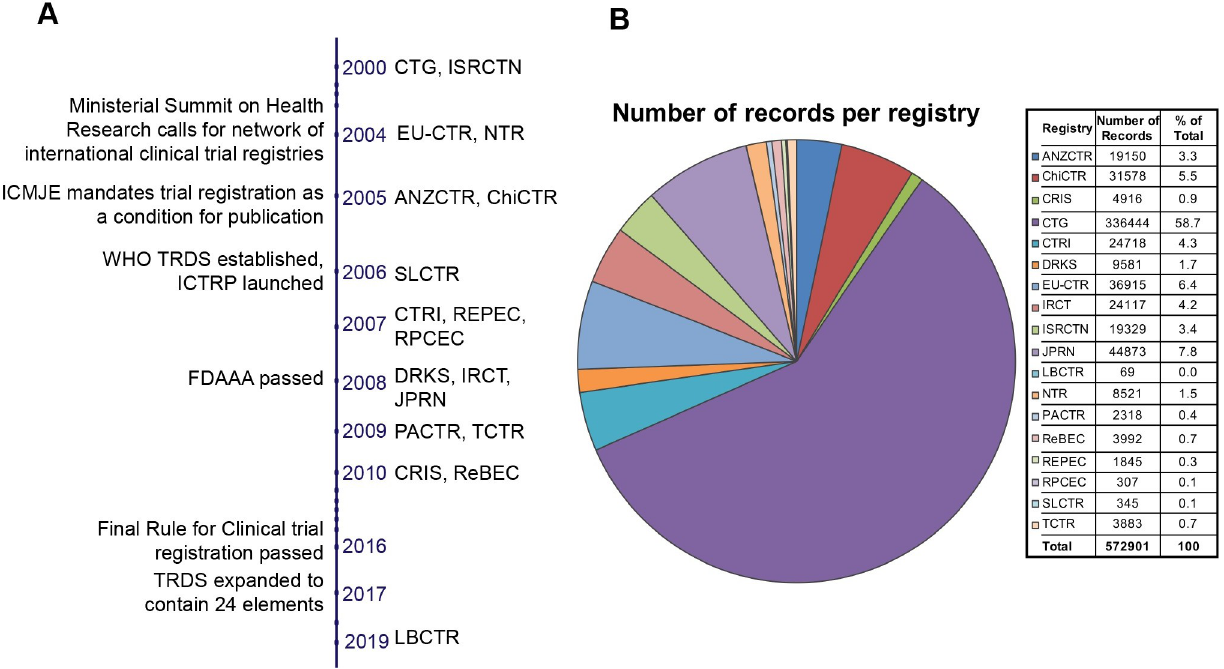
Fig 1. A. The timeline of establishment of the PR+. Key events related to trial registration are also noted. B. Number of records per registry as on 18 April 2020. The pie chart shows the distribution of the number of records in each registry. The actual number, and as a percentage of the total, are also